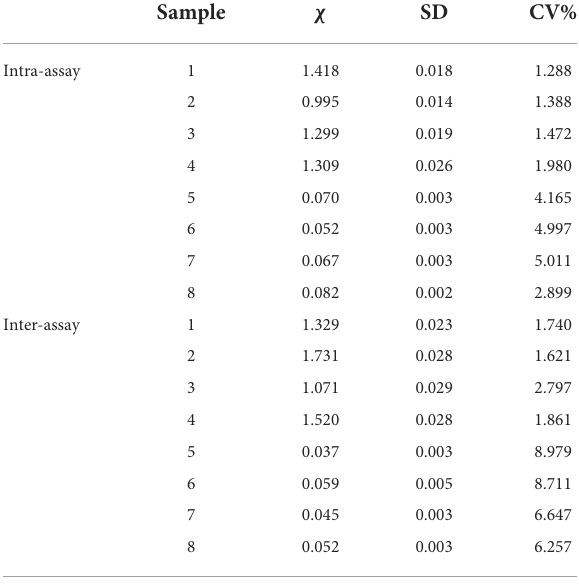
TABLE 1 Determination of Rep based ELISA coefficient of variation (CV) from eight serums (1–4: positive serum; 5–8: negative serum).